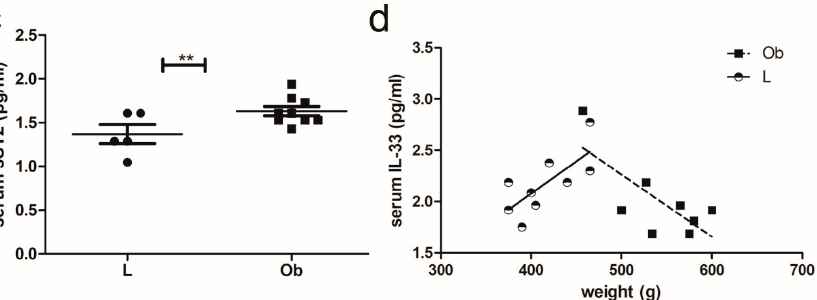
Figure 1. Characterization of IL-33 signaling in ZF rats: ( a ) Graphs showing the weight of rats at sacrifice (*** p < 0.001), ( b ) ELISA assay of serum IL-33. ( c ) ELISA assay of ST2 serum levels and ( d ) graph showing an opposite correlation between IL-33 and weight in Lean (** p < 0.01) versus Obese rats. Student’s t -test: ** p < 0.01; *** p < 0.001. Full square stands for Obese rats, while full circle stands for Lean rats.